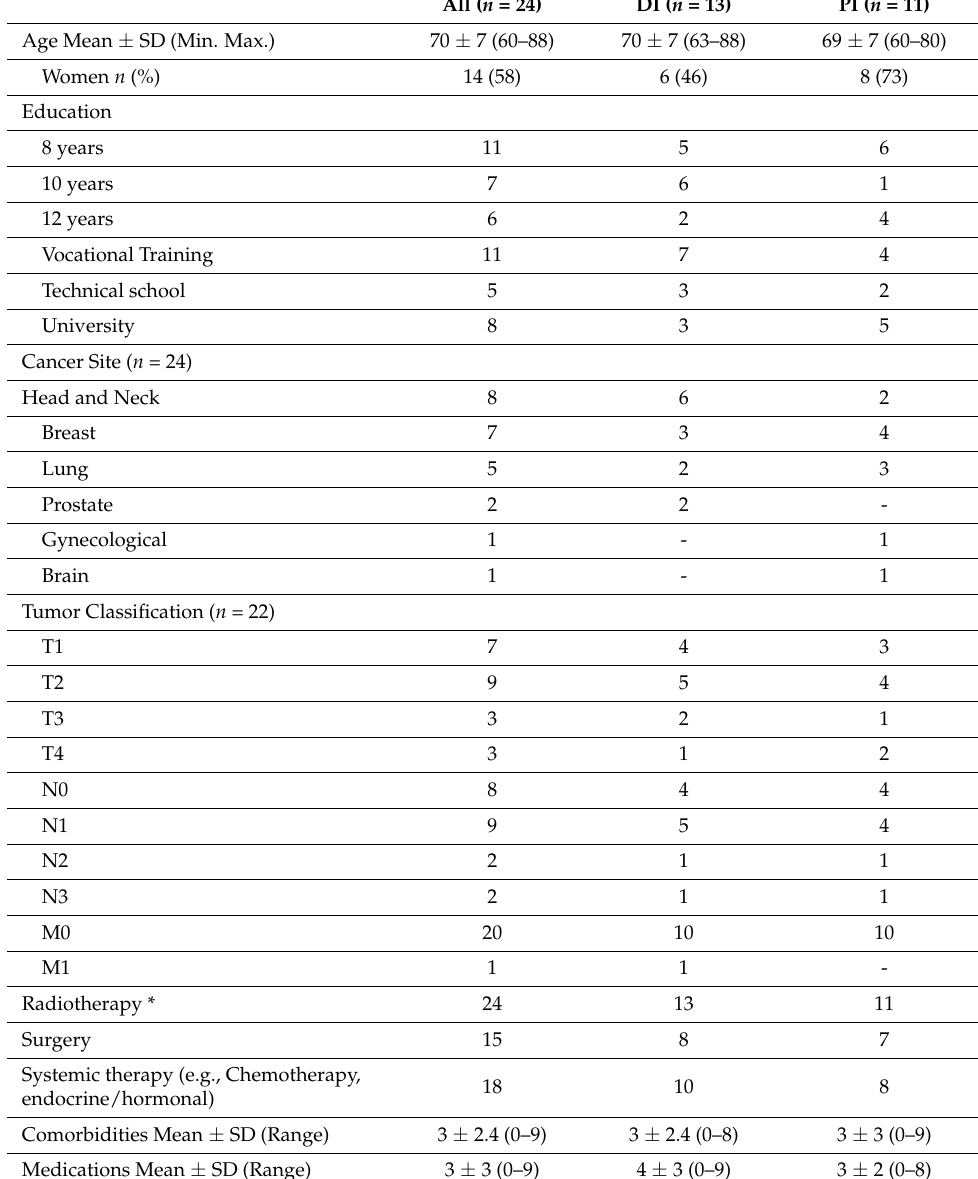
Table 1. Demographic and clinical characteristics of all participants (all), video-based group (DI) and paper-based group